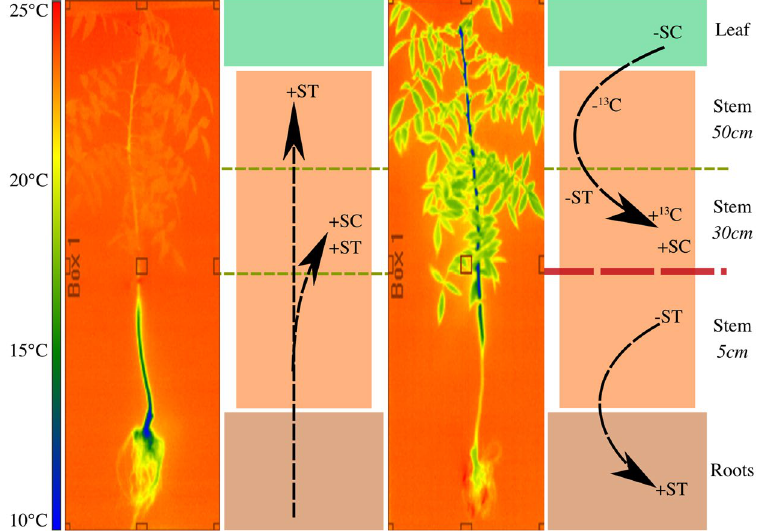
of 13 CO 2 are denoted by ± signs. Arrows represent the proposed path for sugar redistribution and the